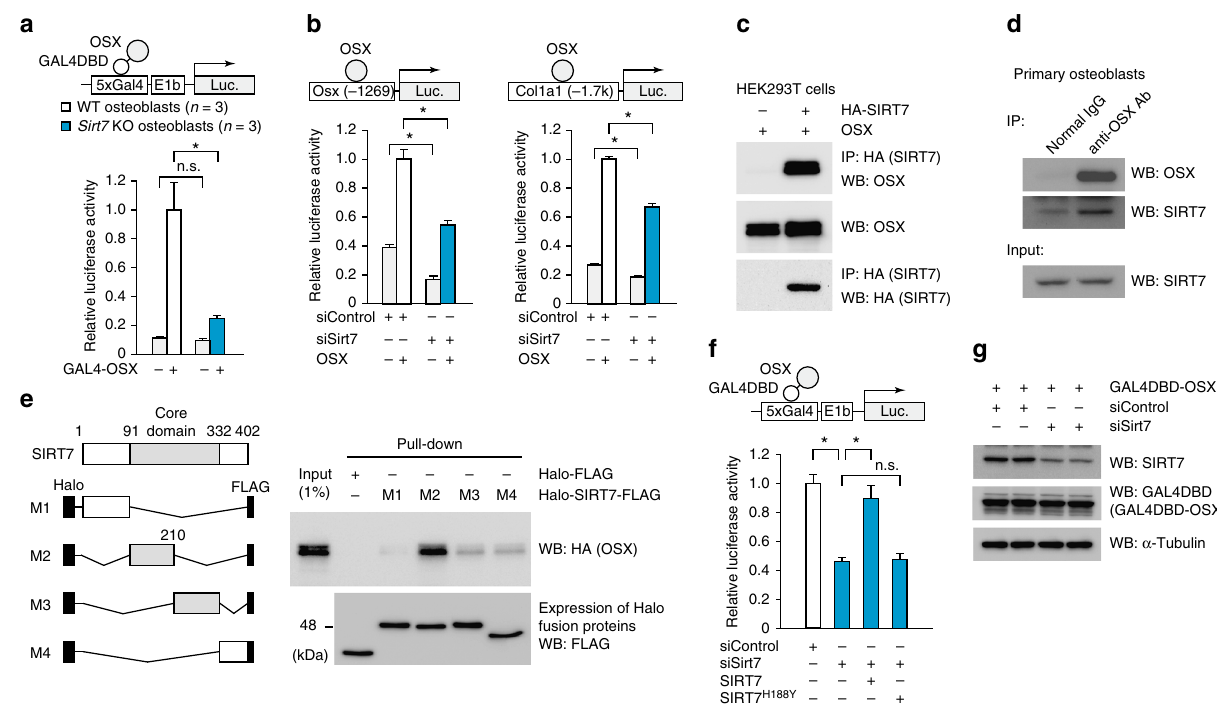
Fig. 5 SIRT7 interacts with OSX and promotes its transcriptional activity. a Transcriptional activity of OSX in Sirt7 KO and WT osteoblasts. Cells were transfected with the GAL4DBD-OSX expression plasmid and the 5× GAL4-luciferase reporter plasmid, and luciferase activity was determined 24 h after transfection. b Transcription of the Osx (left) and Col1a1 (right) enhancer/promoter-driven luciferase reporters in MC3T3-E1 cells. After the indicated siRNA was introduced for 72 h, cells were transfected with the OSX expression plasmid and the indicated luciferase reporter plasmid. The reporter assay was performed 24 h later. n = 3 each. c , d Co-immunoprecipitation assay detecting the interaction between HA-SIRT7 and OSX in HEK293T cells ( c ), and that between endogenous SIRT7 and OSX in primary calvarial osteoblasts differentiated for 6 days ( d ). e Mapping the site of interaction between SIRT7 and OSX. Pull-down assay of Halo-SIRT7-FLAG deletion mutants was performed with lysate of OSX-HA overexpressing HEK293T cells. Expression of Halo- FLAG and Halo-SIRT7-FLAG proteins (M1 – 4 deletion mutants; amino acids 1 – 90 (M1), 91 – 210 (M2), 211 – 332 (M3), and 333 – 402 (M4)) was determined by WB. f Effect of SIRT7 overexpression on transcriptional activity of OSX. MC3T3-E1 cells were transfected with the indicated siRNA, and 72 h later were transfected with the GAL4DBD-OSX expression plasmid, the 5× GAL4-luciferase reporter plasmid, and SIRT7 or SIRT7 H188Y expression plasmid. The reporter assay was performed after 24 h. n = 3 each. g GAL4DBD-OSX protein level analyzed by WB under the conditions in h . WB western blotting; IP, immunoprecipitation. Data are shown as the mean ± SEM. Statistical signi fi cance was determined by Student ’ s t -test. * p <